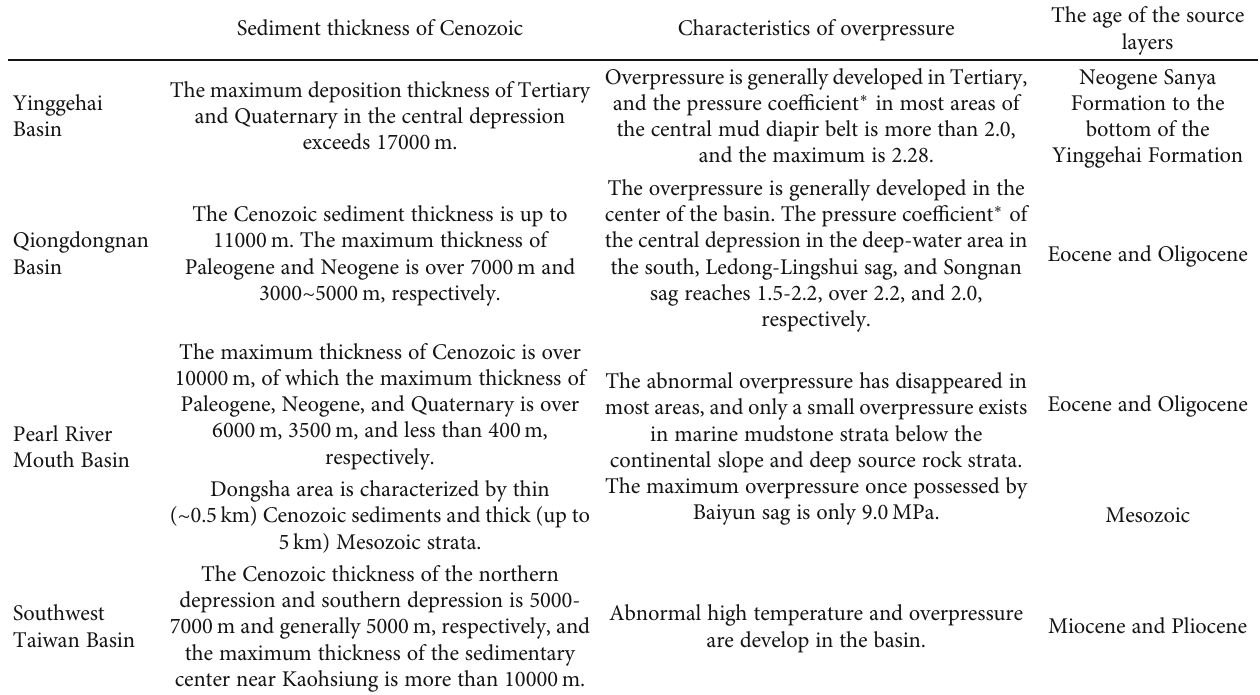
Table 2: Characteristics of the Yinggehai Basin, Qiongdongnan Basin, Pearl River Mouth Basin, and Southwest Taiwan Basin in the northern South China Sea [43, 57, 65, 67,